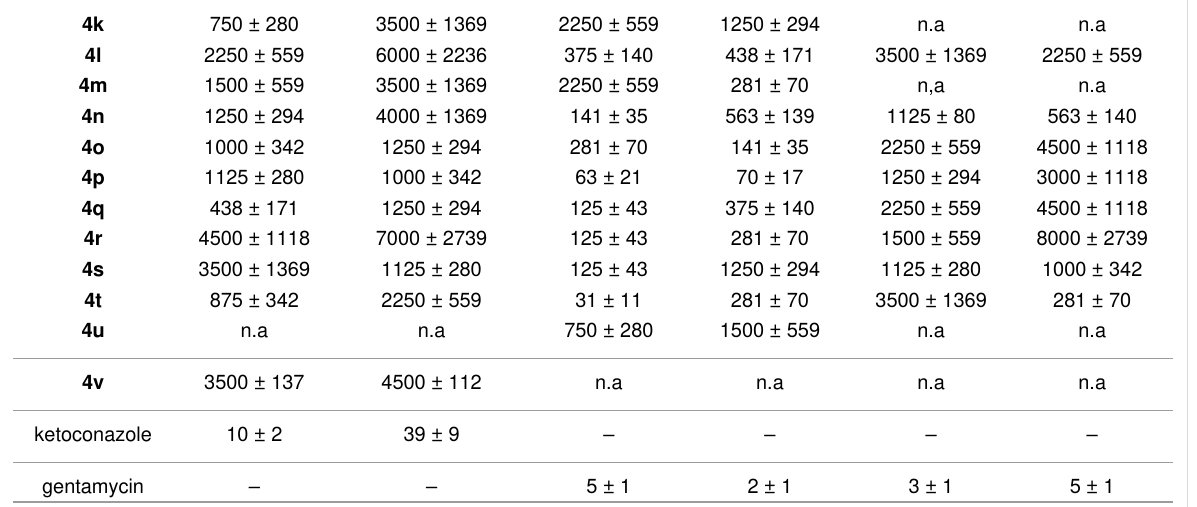
Table 2: Minimum inhibitory concentrations (MIC, µg/mL) of the synthesized compounds determined by microdilution method.